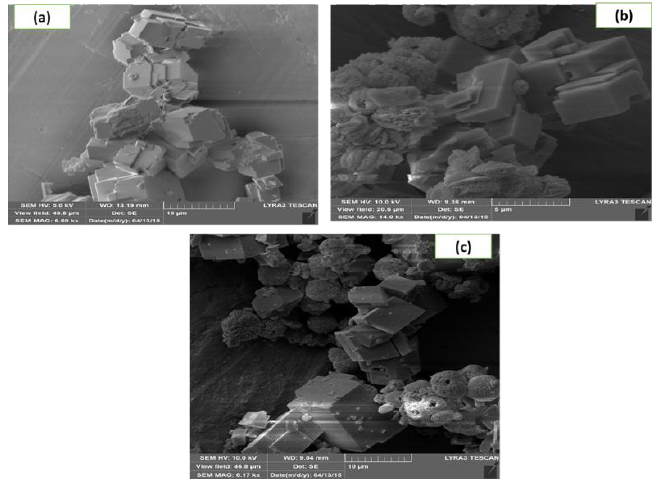
Figure 7. Scanning Electron Microscopy (SEM) images for deposits of ( a ) untreated control, ( b ) treated with ATMP, and ( c ) ultrasonicated sample after 60 min.